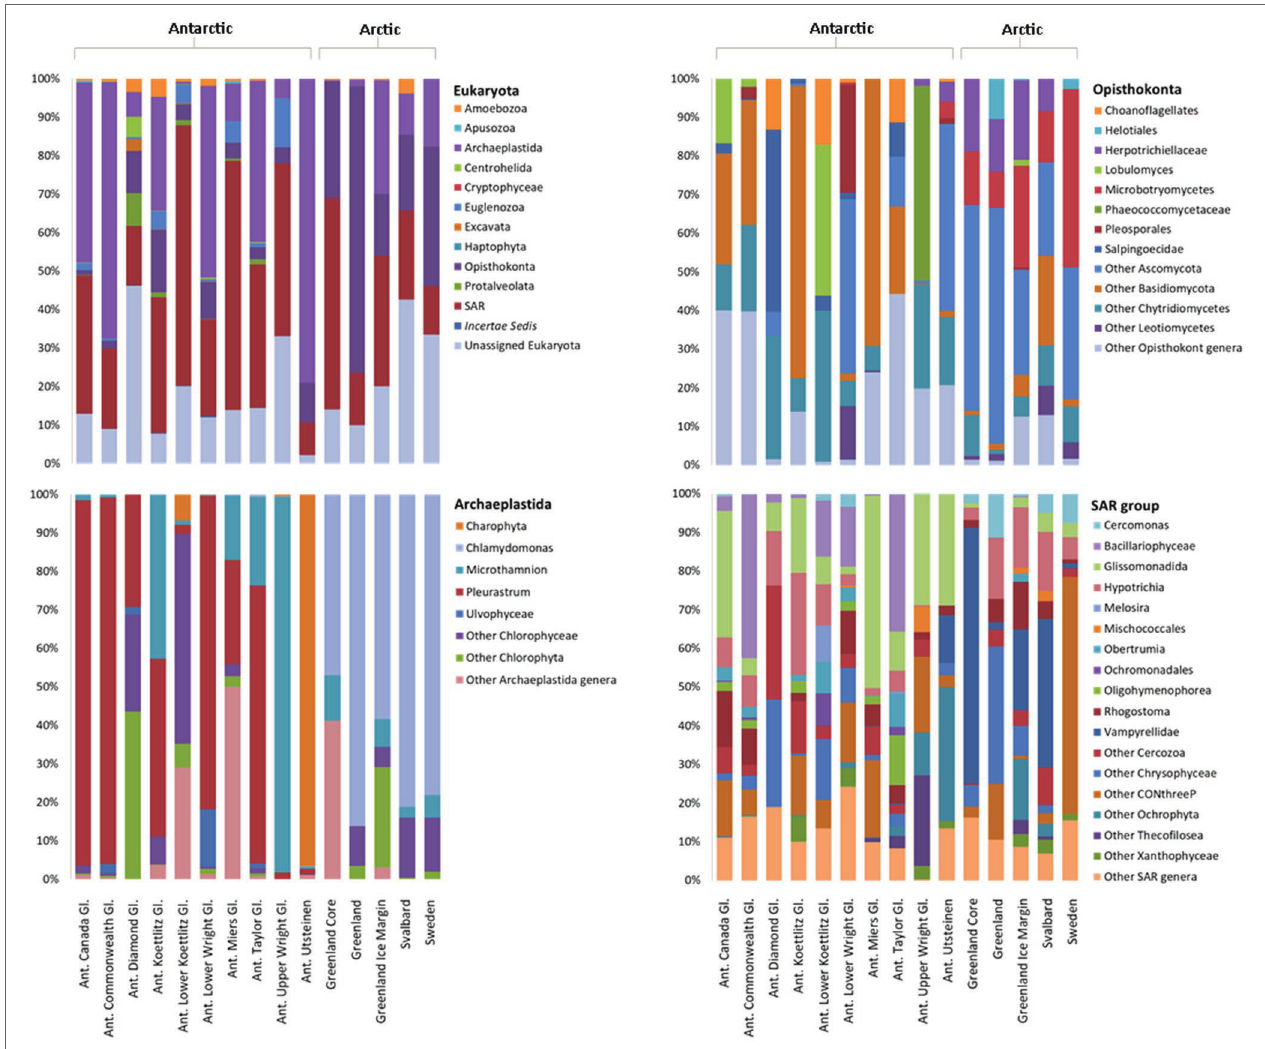
FIGURE 6 | Relative abundance of microbial eukaryotes in Arctic and Antarctic cryoconite, averaged by glacier. Metazoa were excluded from these data. Top left: eukaryotic phyla. Phyla contributing to <1% of the total abundance are not included. Remaining panels: Relative abundance of genera within the top three most abundant phyla. Genera contributing to <1% of the total abundance are grouped as “Other.” Where a genus was unknown, lowest rank known is shown. Taxa were assigned according to the SILVA database. “Ant. Gl.” denotes Antarctic